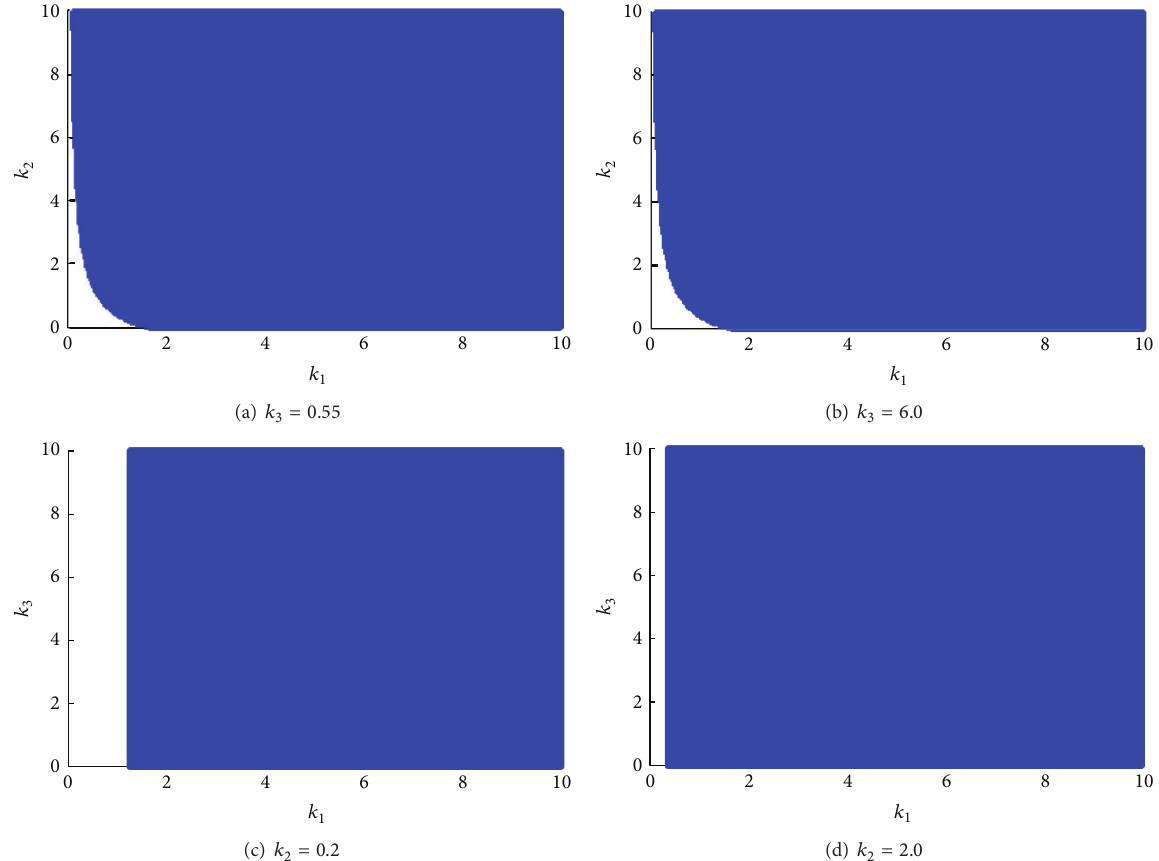
Figure 2: Region of “controllability” for different fixed values of 𝑘 3 (a), (b) and 𝑘 2 (c),